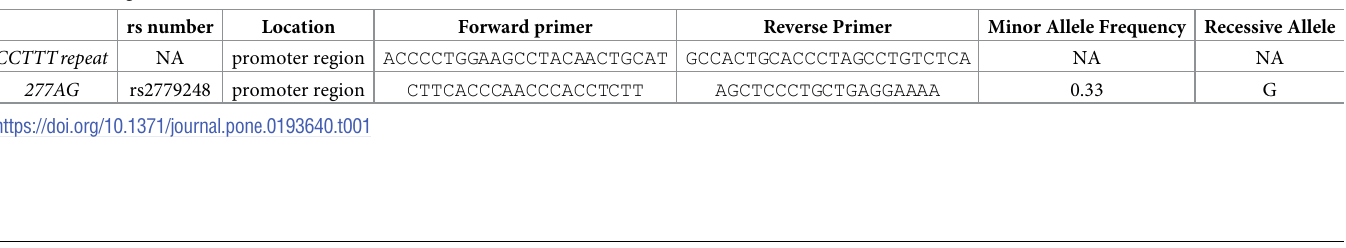
Table 1. Investigated SNP